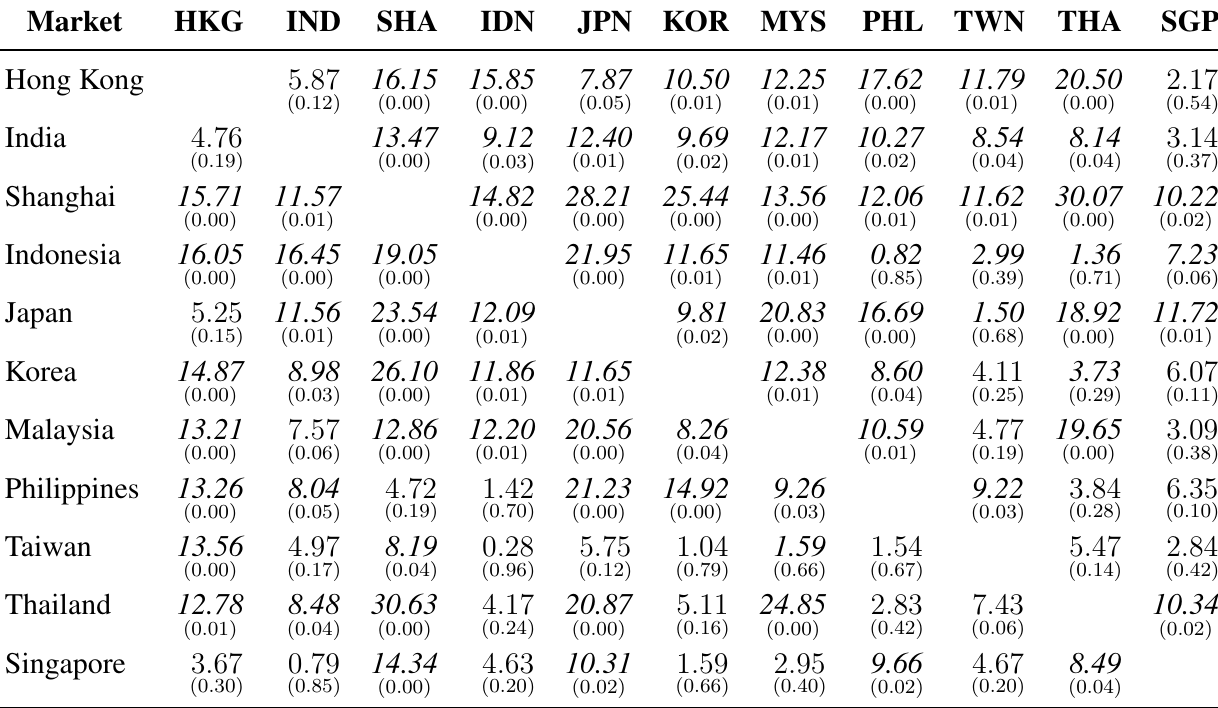
Table 14. LM test statistics for the bivariate SV model with a single common volatility.